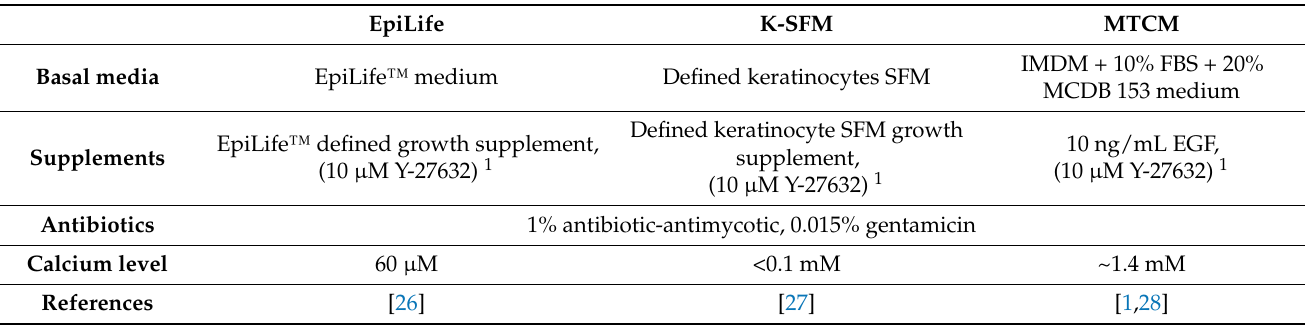
Figure 1. Photographs of rat lingual epithelia and rat lingual keratinocytes (RLKs). ( A ) A dorsal lingual epithelium containing both fungiform papillae and non-taste filiform papillae (Eg); a dorsal lingual epithelium containing only non-taste filiform papillae (Ed); a ventral lingual epithelium without any lingual papillae (Ev). The white arrow indicates a fungiform taste papilla. Scale bars, 500 µ m. ( B ) Representative images of lingual keratinocytes cultured in EpiLife, K-SFM, and MTCM growth media. P0 stands for primary culture whereas P1 and P2 represent passage 1 and 2, respectively. Images were captured under 10 × magnification. The time points at the bottom-right corners of each panel indicate the time when the photographs were taken after primary culture or subcultures. Table 1. Growth media used for primary culture of rat lingual keratinocytes